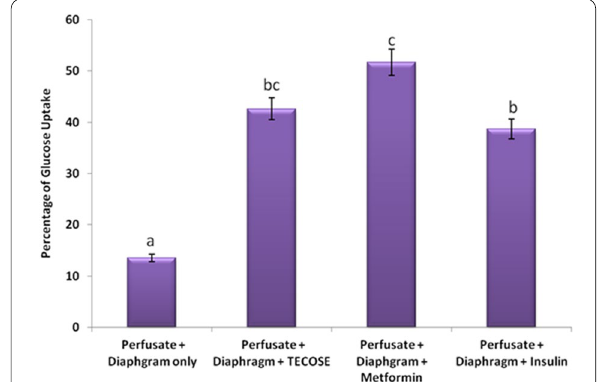
Fig. 9 Percentage glucose uptake by diaphragm in the control and treatment groups. Values are expressed as mean with different Tukey superscripts are statistically significant at p <